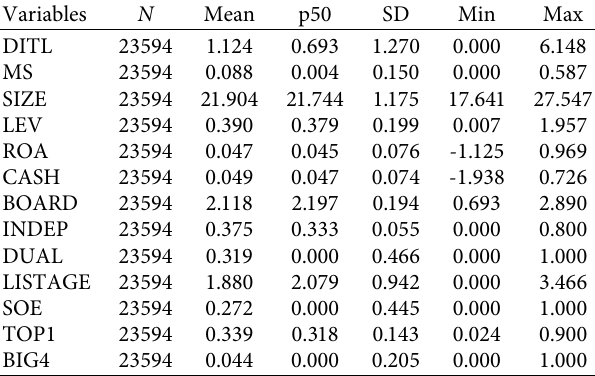
Table 1: Results of descriptive statistical analysis.